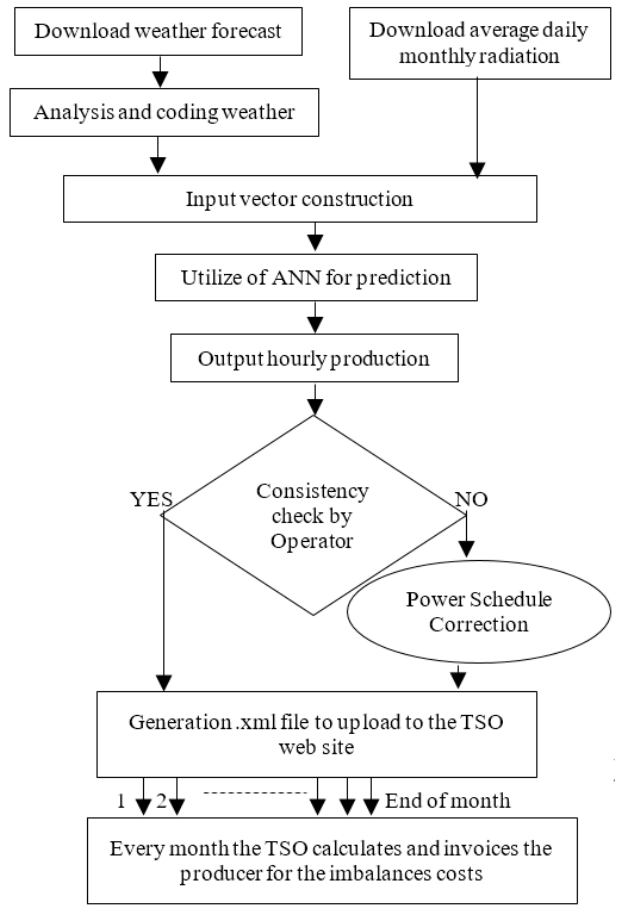
Figure 8. Flowchart of the model operations.